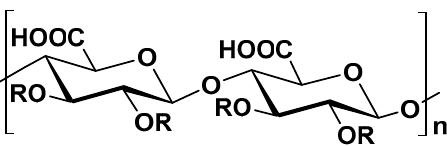
Figure 2. Structure of β -(1,4)- D -polyglucuronic acid (PGU) from Sinorhizobium meliloti M5N1CS. With R = H or COCH 3 (acetyl group).